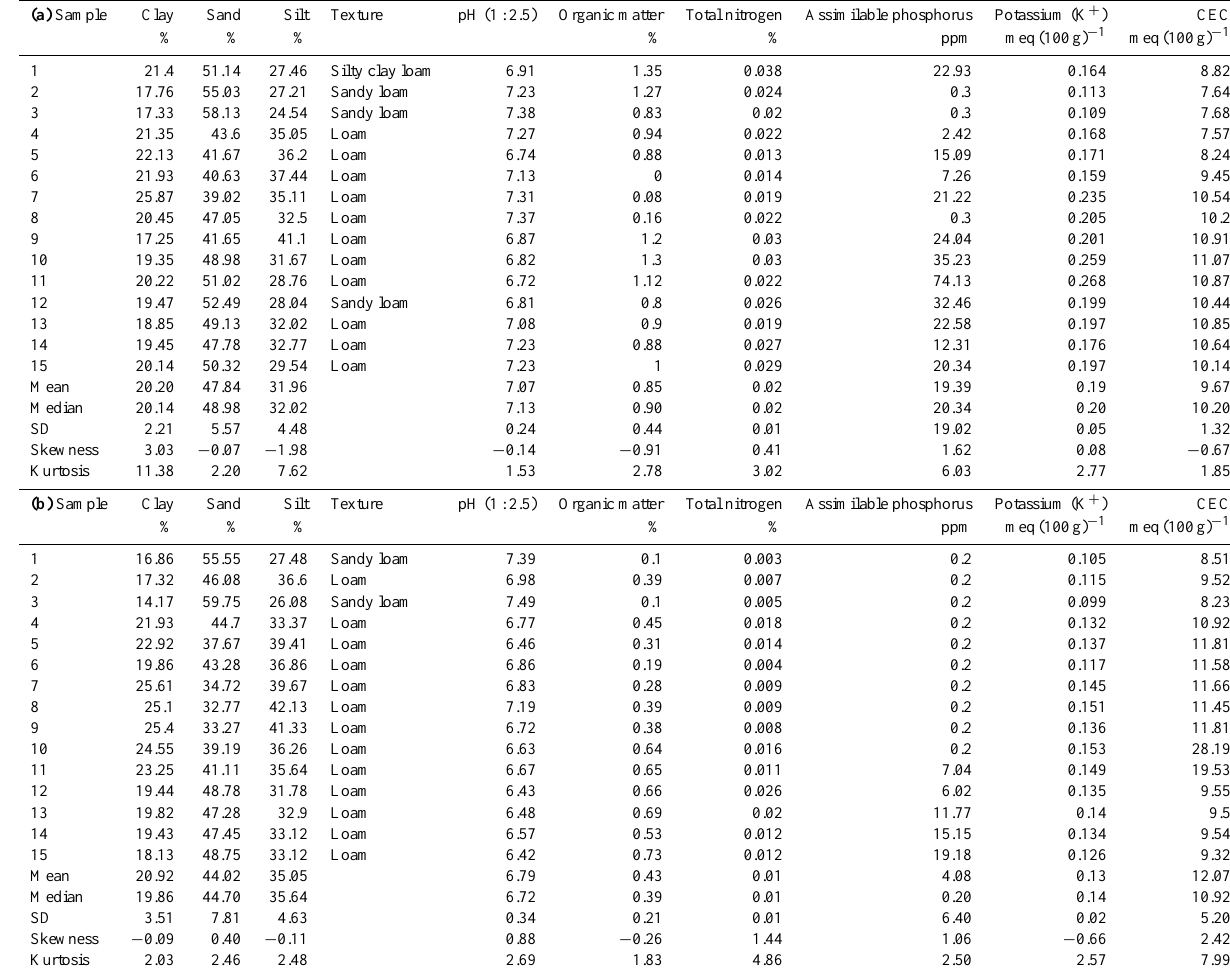
Table 1. (a) Soil composition from 0 to 0.30m of the vineyard assay. (b) Soil composition from 0.30 to 0.60m of the vineyard